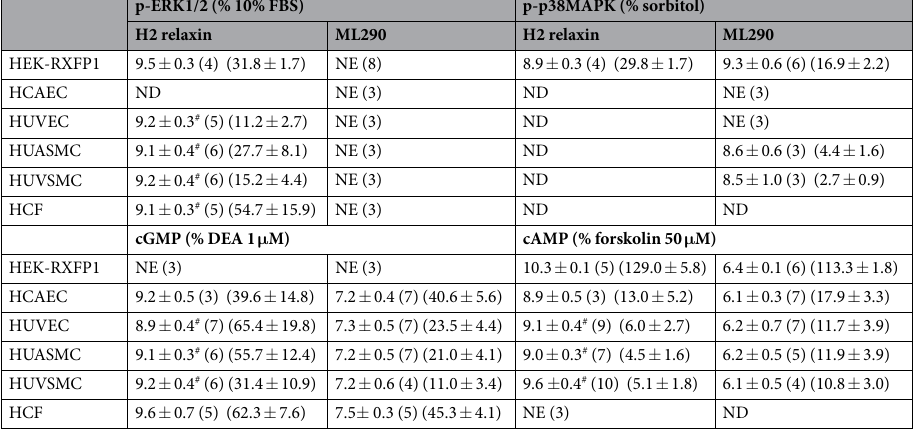
Table 1. The potency of ML290 and relaxin in HEK-RXFP1 and human primary vascular cells for p-ERK1/2, pp38MAPK, cGMP and cAMP accumulation. Note: # Indicates data taken from our previous publication conducted in the same cells 6 . Efficacy (below in brackets) expressed as a % of control responses for each pathway. N numbers in brackets. NE – no effect; ND – not determined.